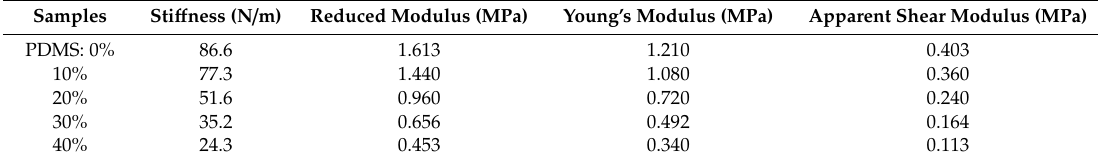
Table 1. Mechanical properties of coatings prepared from varied weight ratios of hybrid